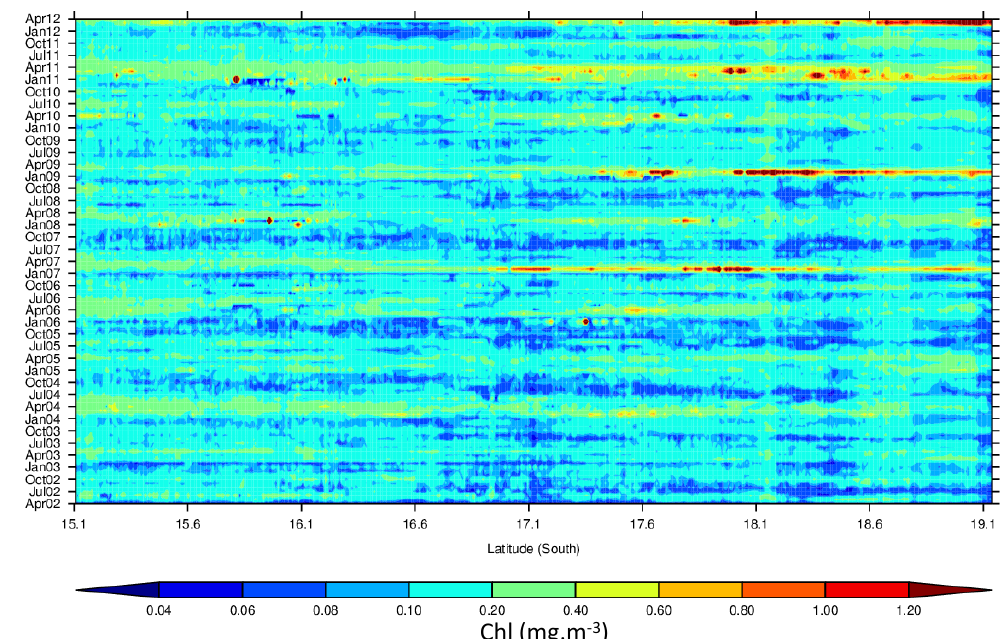
Figure 15. Latitude-time plot of Chl for the GBRW